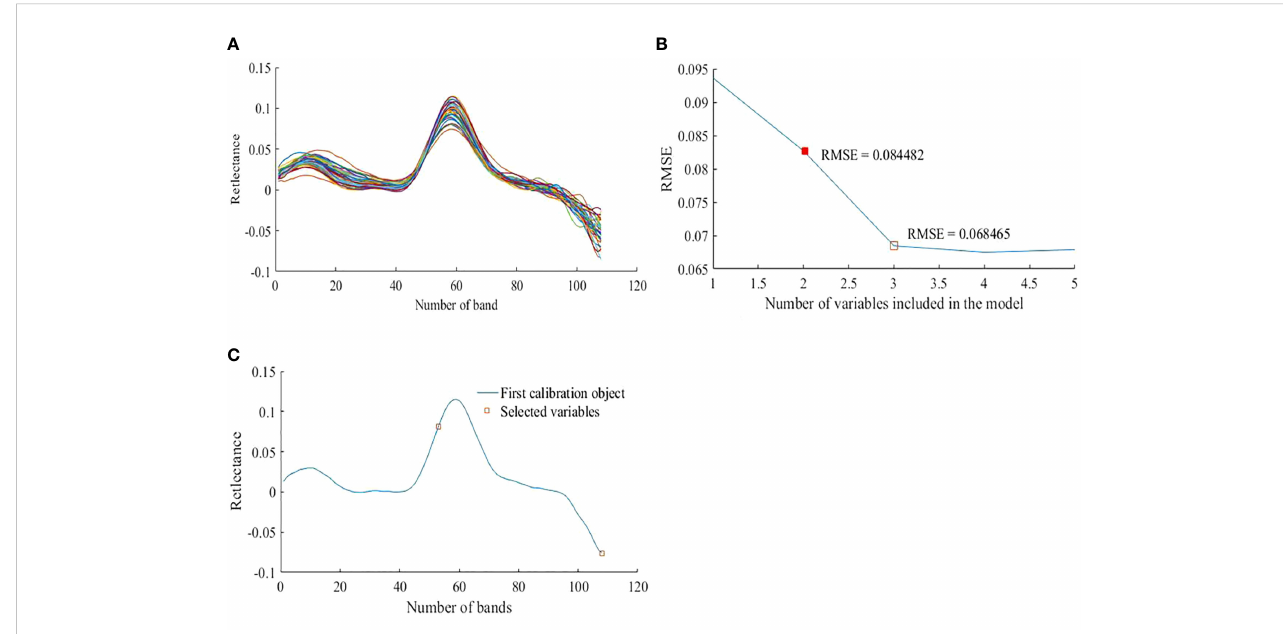
FIGURE 7 Spectra Screened by the SPA. (A) Spectrum diagram of Savitzky-Golay smoothing (B) The curve of root mean square error (n = 24) (C) . Characteristics variable selection